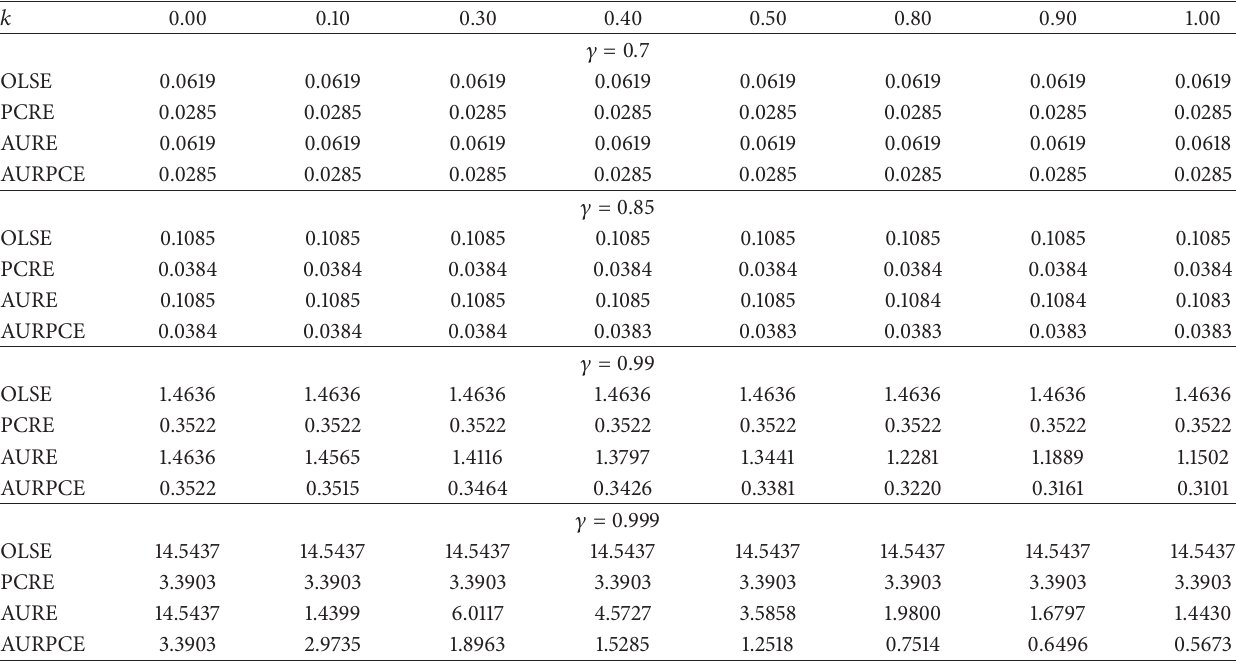
Table 1: MSE values of the OLSE, PCRE, AURE, and AURPCE.